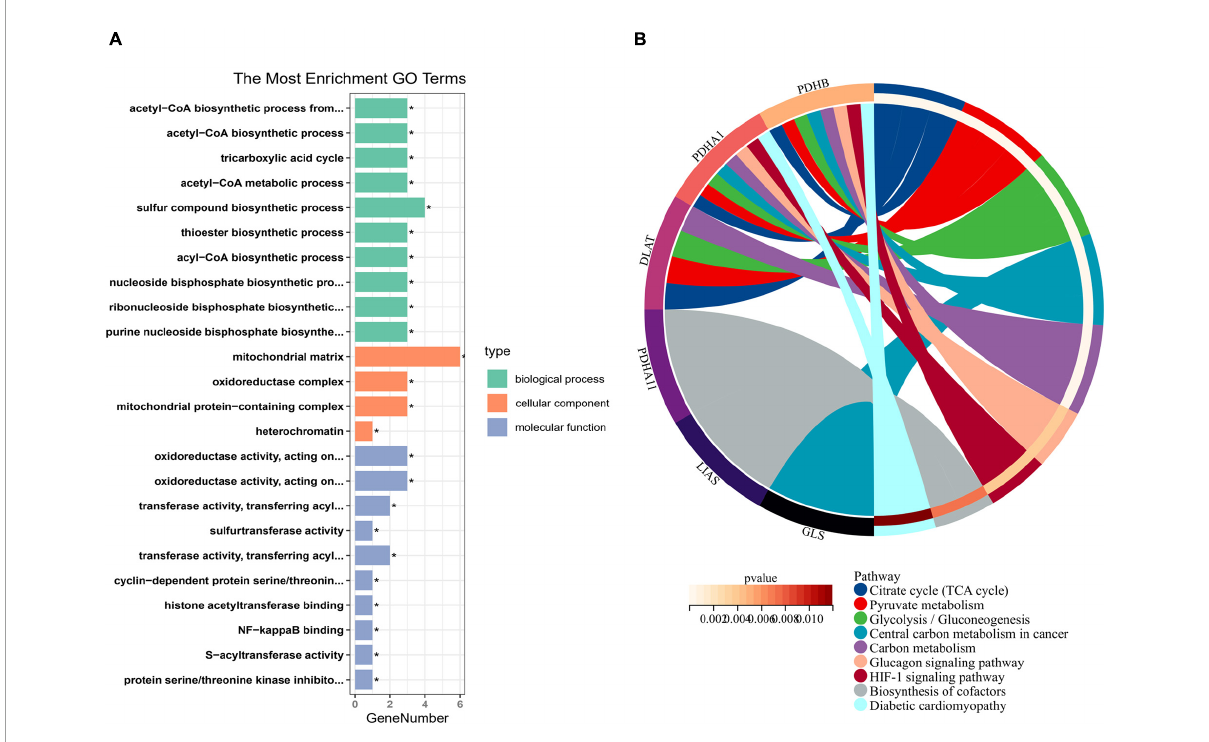
FIGURE2 Enrichment analysis of cuproptosis-related genes (CRGs). (A) The histogram of GO analysis (BP, CC, and MF). (B) The Circos of Kyoto Encyclopedia of Genes and Genomes (KEGG) analysis. * P < 0.05.